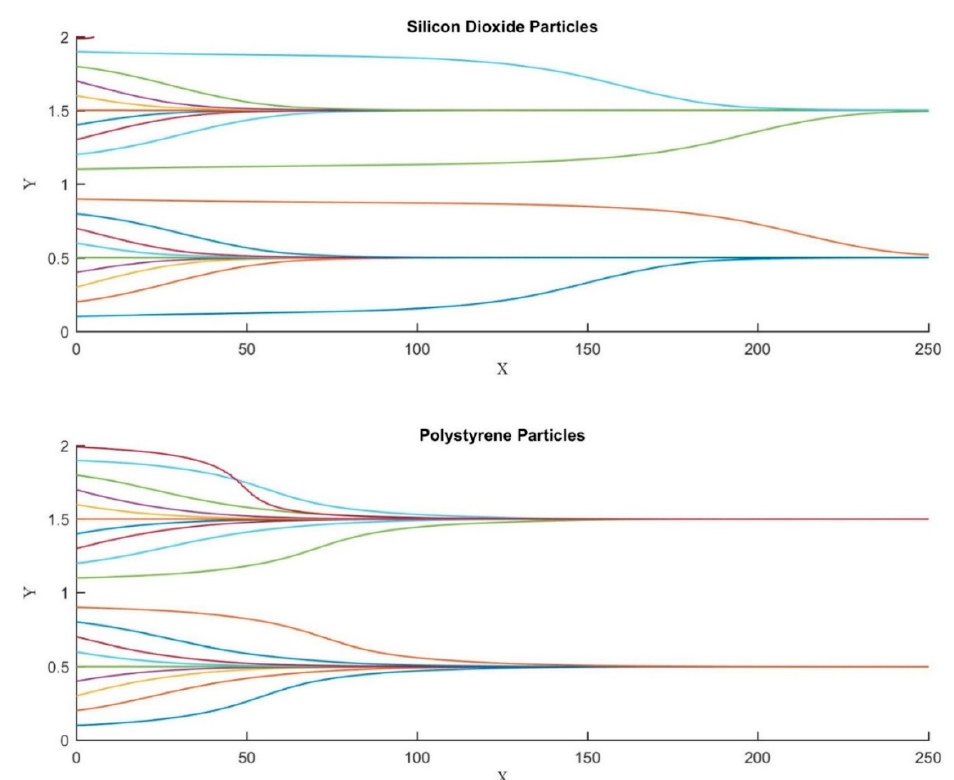
Figure 8. The impact of particle properties on its trajectory. Silicon dioxide ( 𝛒 𝐞 = 2000 Kg/m 3 and 𝛆 𝐞 = 3.5 F/m) and polystyrene ( 𝛒 𝐞 = 1060 Kg/m 3 and 𝛆 𝐞 = 2.55 F/m) microparticles. All other simulation parameters are kept the same for both figures. X, Y, and Z are the dimensionless lengths x/L, y/L, and z/Hch, respectively.